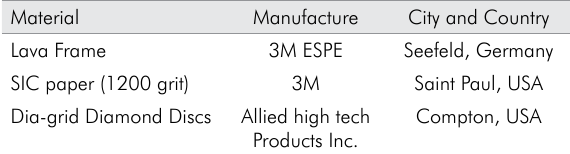
Table 1. Material, respective manufacturers, city and country.